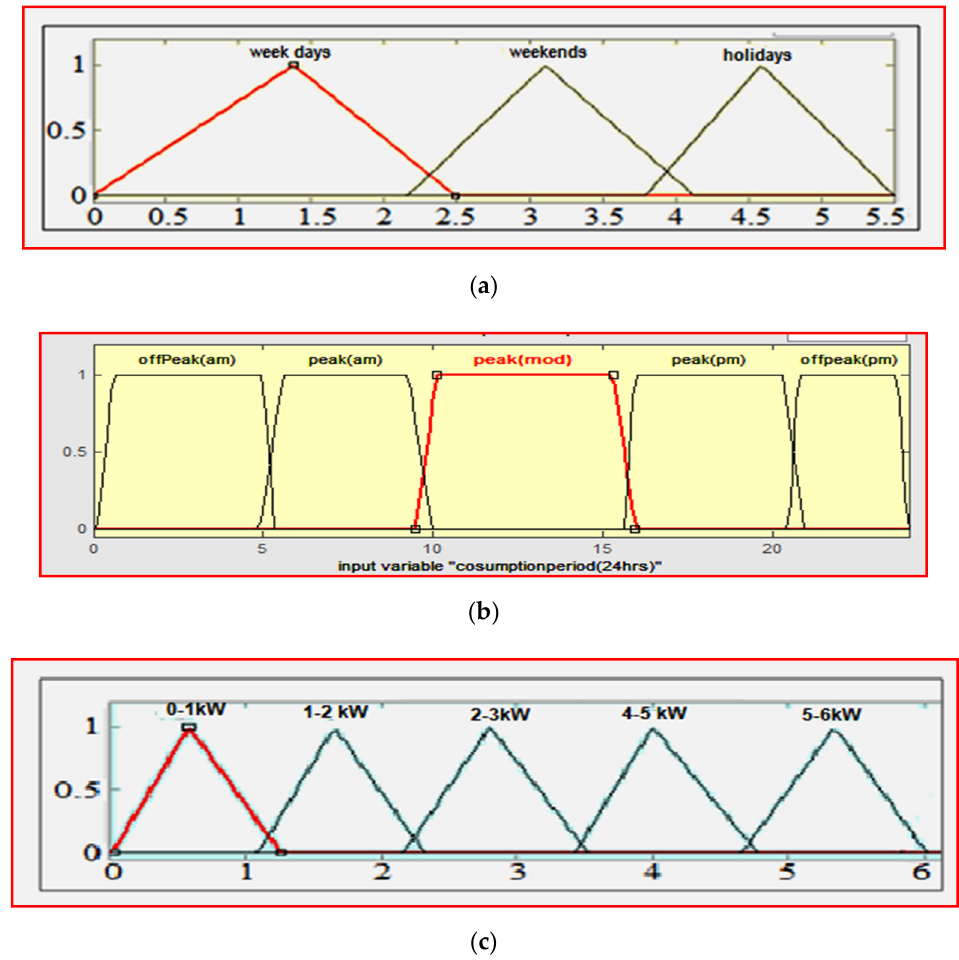
Figure 7. Forecasting system ( a ) input variable “daily load variation” (fuzzification variable versus power in kW) ( b ) input variable “consumption period for 24 h” (fuzzification variable versus time in hours) ( c ) output variable “forecasted load” (fuzzification variable versus power in kW).